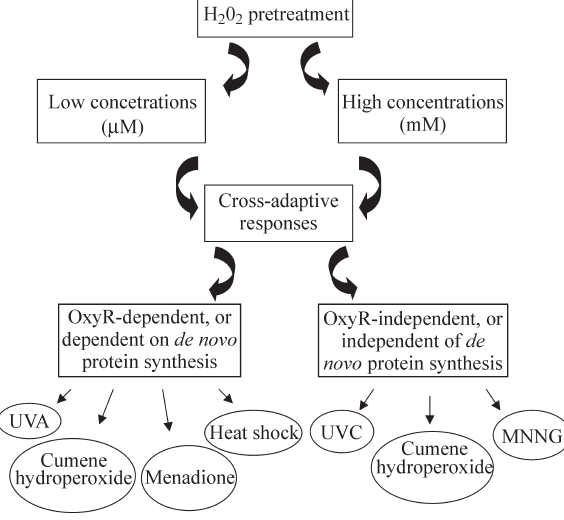
Figure1 -Cross-adaptiveresponsesinducedbyloworhighH 2 O 2 concen- tration operate through different